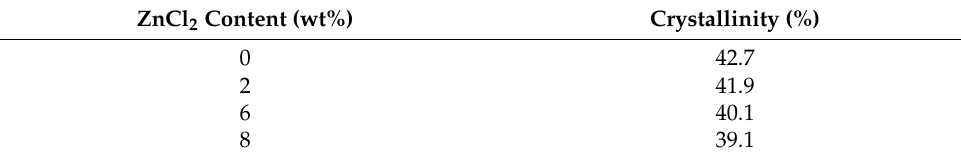
Figure 10. XRD diffractogram of EVA/CWF composites at different ZnCl 2 contents. Table 2. Percentage crystallinity of EVA/CWF composites at different ZnCl 2